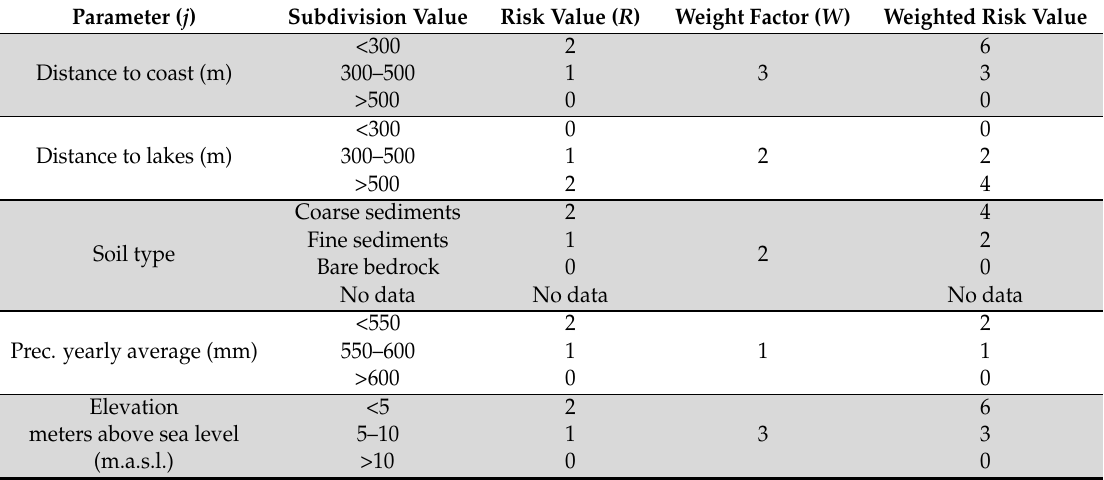
Table 2. Risk parameters of saltwater intrusion used in the risk analysis, including subdivisions, risk values, and weight factors; see [16] for further